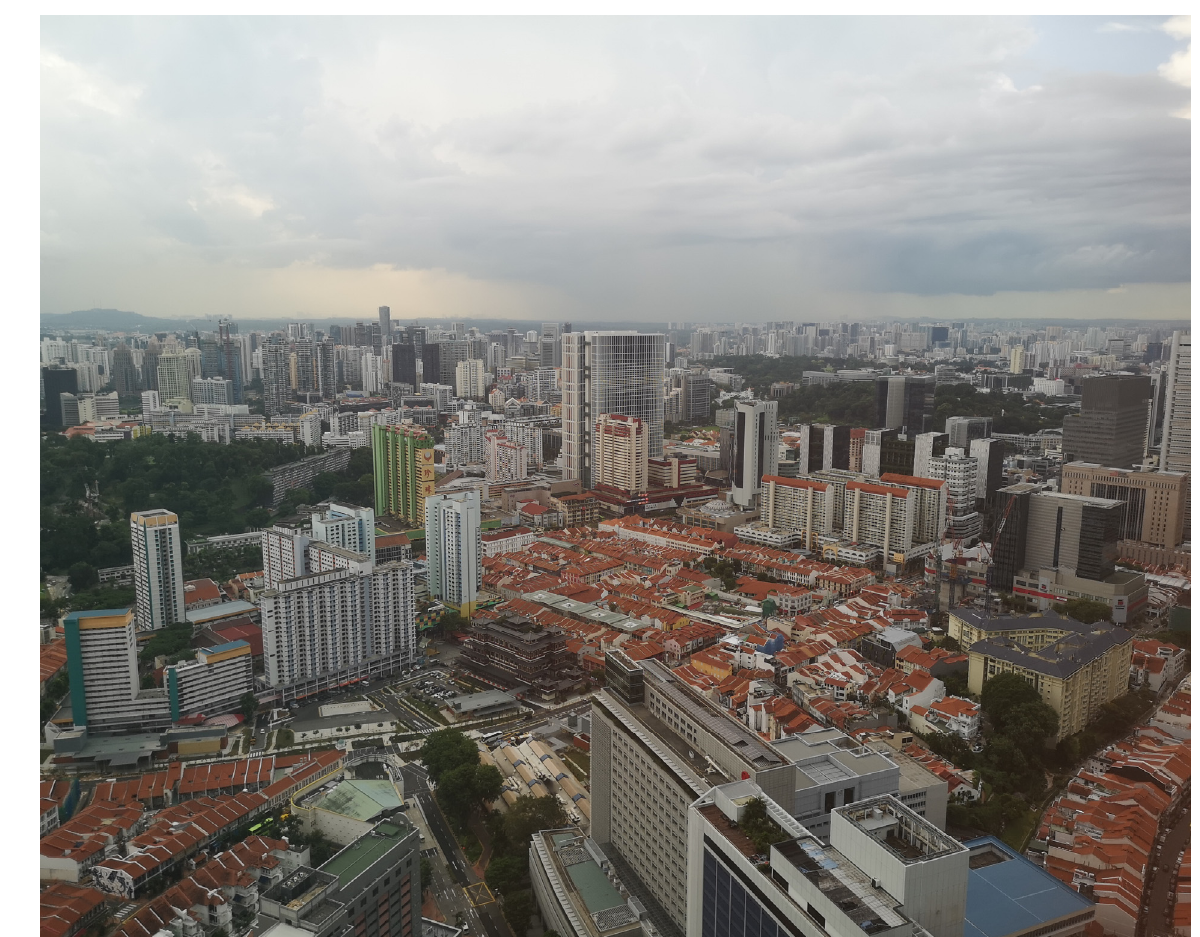
Figure 1. Downtown area in Singapore, where modernity and history coexist.